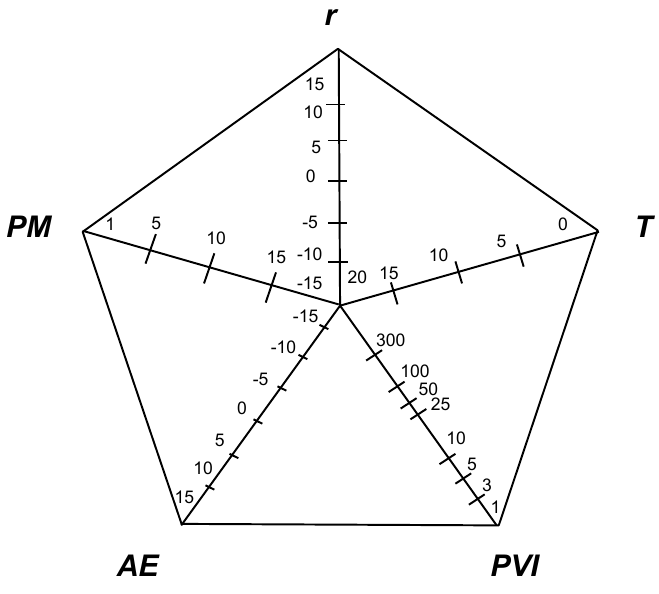
Figure 2. Microeconomic stabilization pentagon